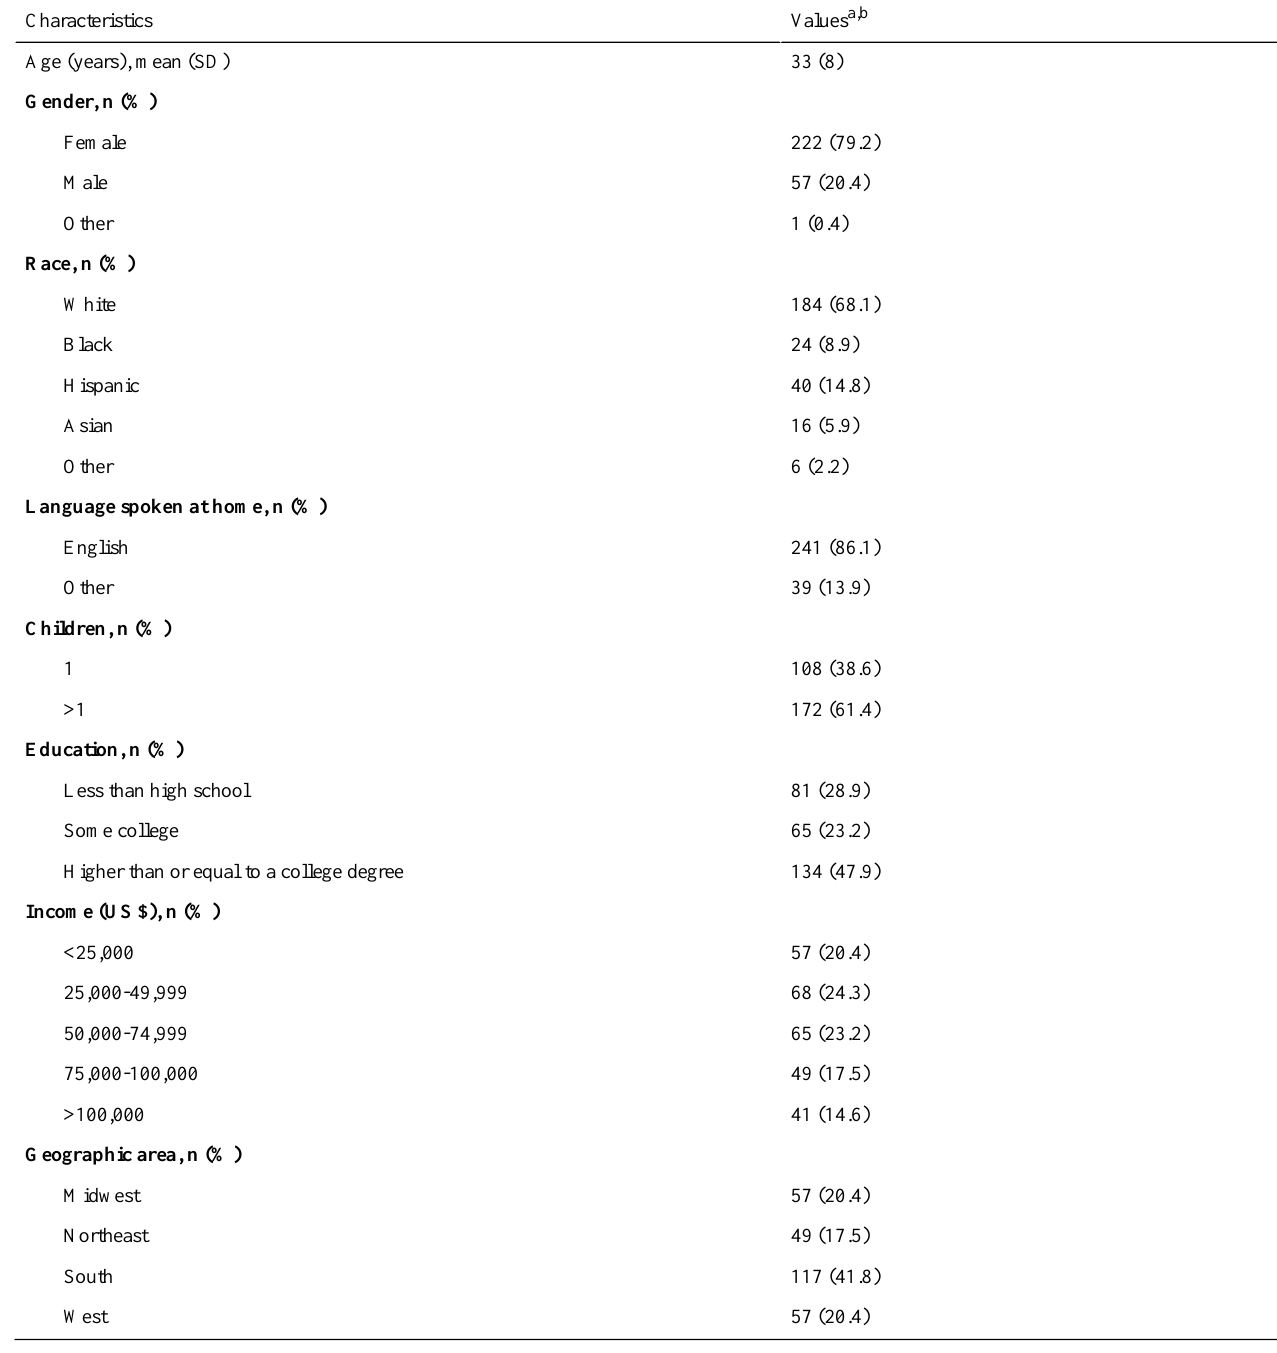
Table 1. Descriptive statistics for the study sample